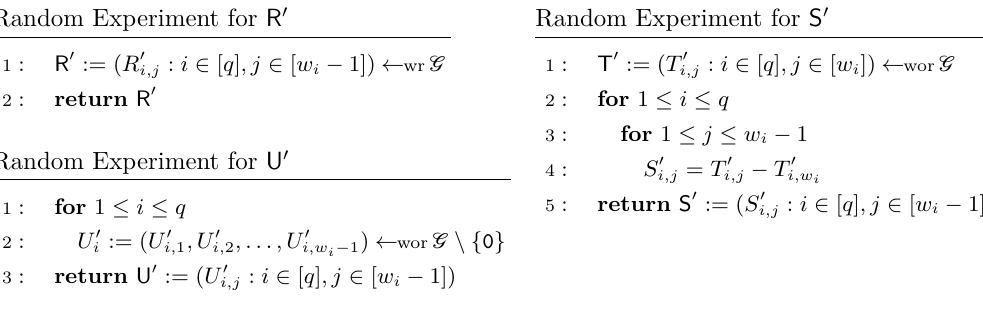
Figure 3.3: Description of sampling methods of random variables R 0 , S 0 and U 0 for variable widths w 1 , . . . , w q .